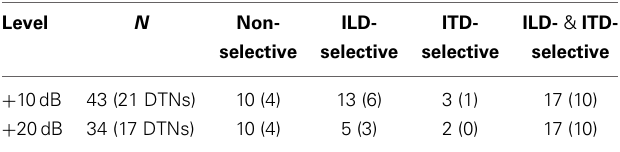
Table 8 | Number of cells with ILD-selective and ITD-selective responses at two suprathreshold